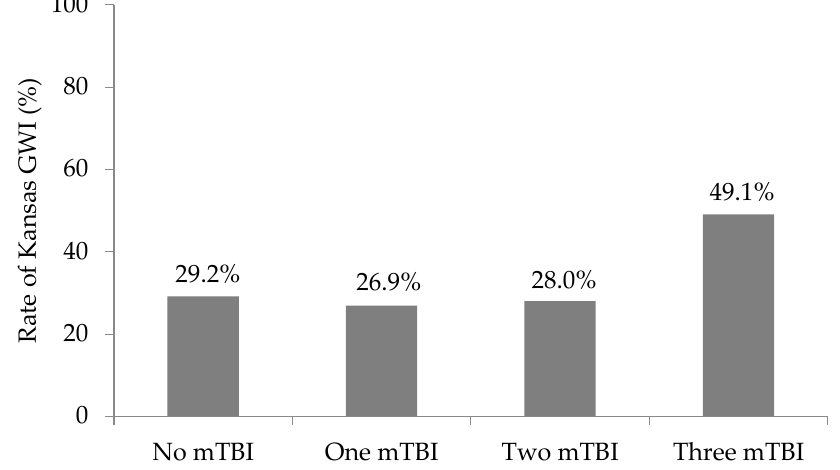
Figure 3. Rate of Kansas Gulf War Illness (GWI) criteria by mild traumatic brain injury (mTBI) group. p = 0.016.